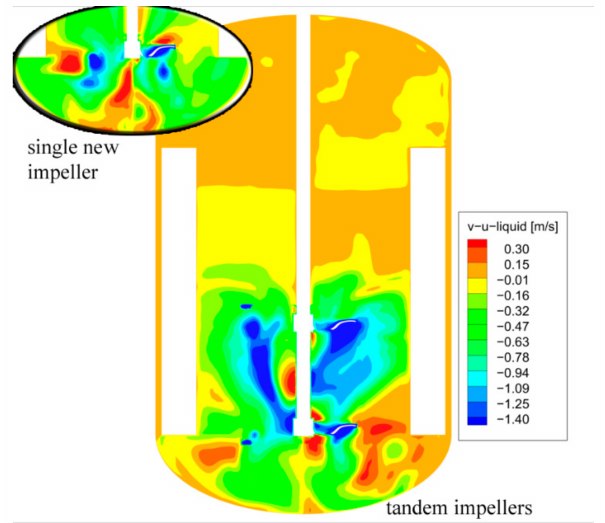
Figure 8. Tangential velocity distribution of liquid phase, single new impeller vs. new impellers in tandem, instantaneous